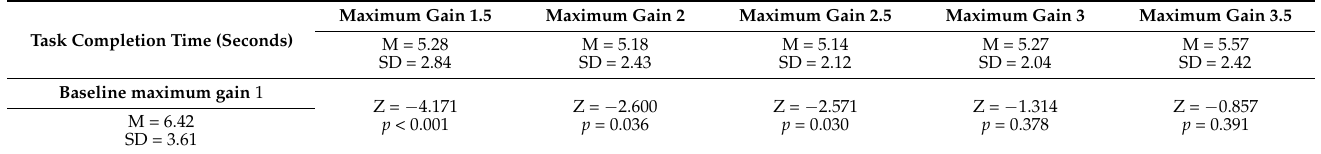
Table 2. Mean task completion times with standard deviation values and results of Wilcoxon signed- rank